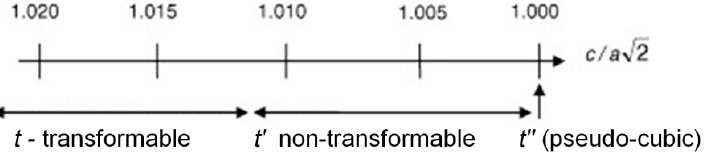
Figure 1. The tetragonal forms of Y-TZP as a function of the tetragonality and transformability (adapted from Viazzi et al. [11]).